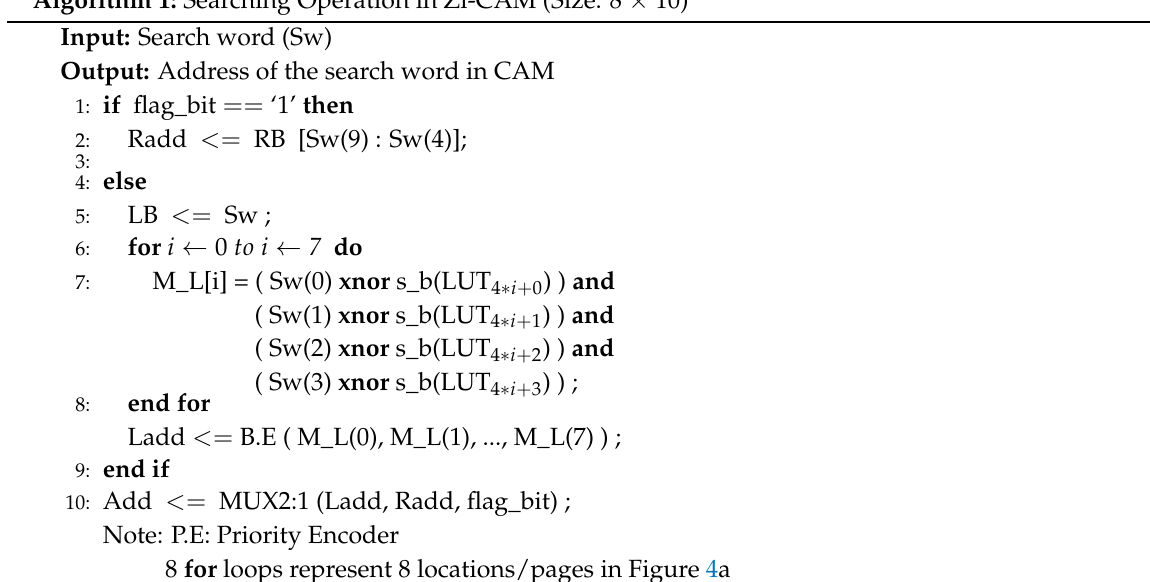
Algorithm 1: Searching Operation in Zi-CAM (Size: 8 ×